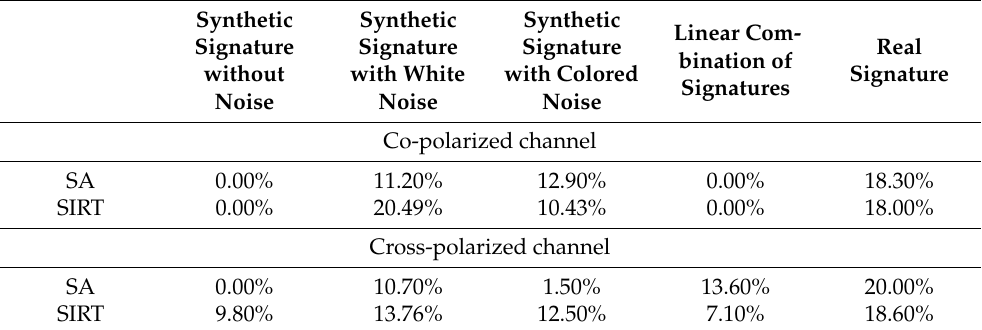
Table 12. Values of average errors for SA- and SIRT-based methods for each tested data set. Recog- nized signatures are specified in